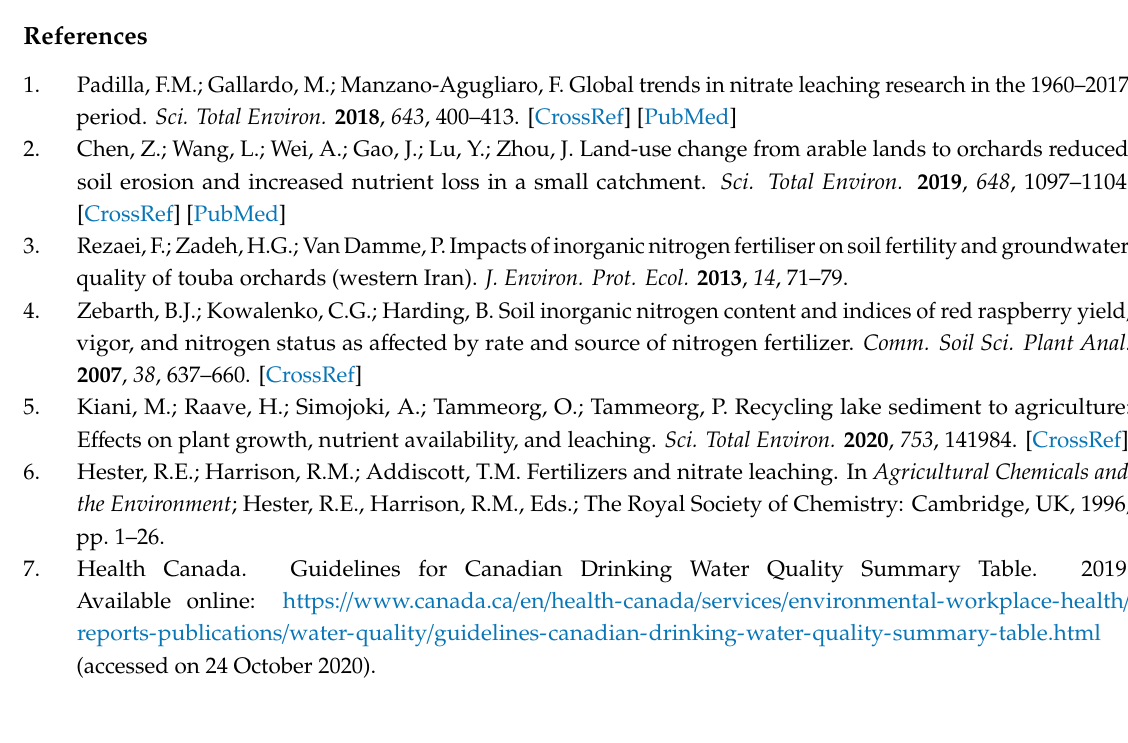
Table S1: Pearson’s correlation matrix among berry yields and chemical properties of soil and